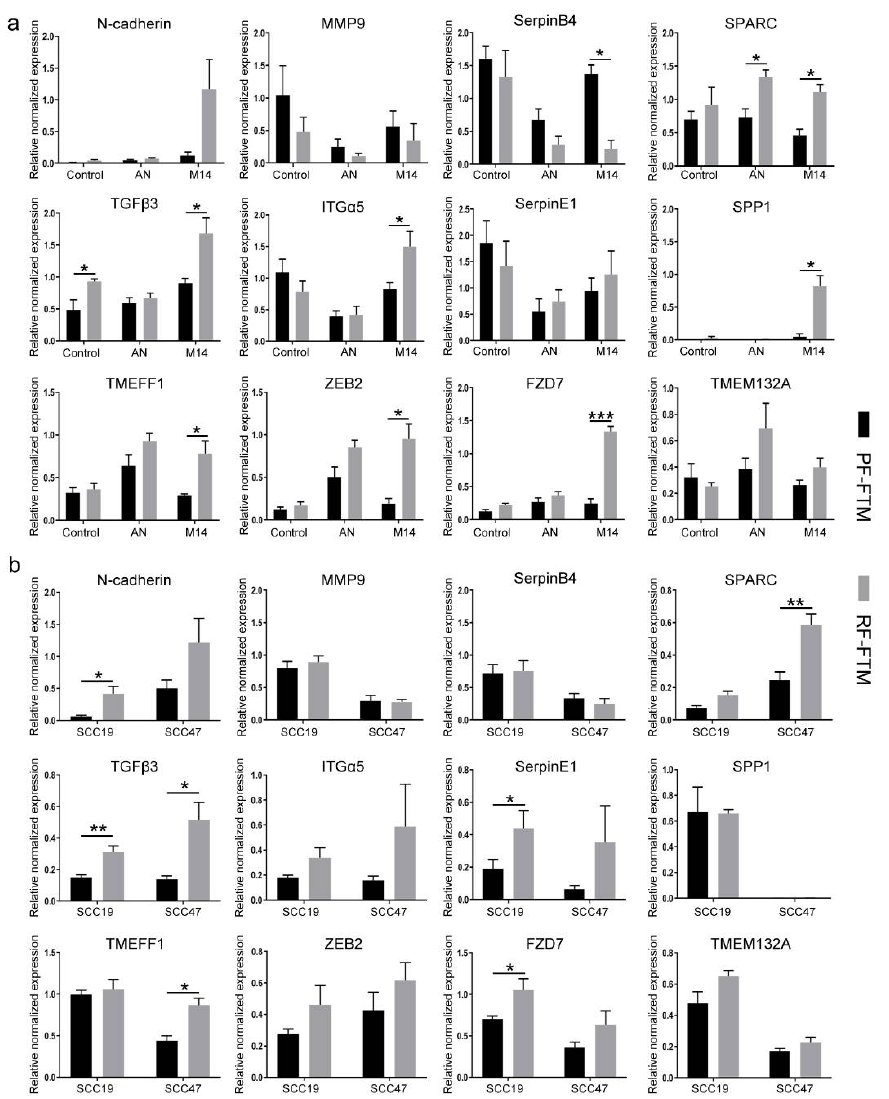
Figure 4. qPCR analysis of the EMT markers in melanoma or HNSCC FTMs. ( a ) Melanoma FTMs. ( b ) HNSCC FTMs. Data was collected from three independent experiments and is presented as mean ± standard deviation (SD); * p < 0.05, ** p < 0.01, *** p < 0.001.